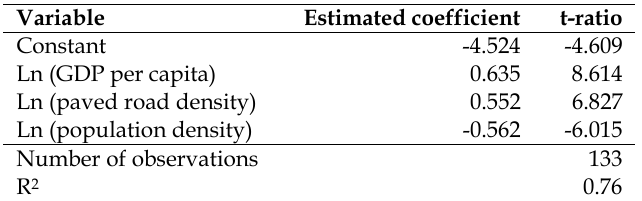
Table 1. Country estimation results for motorisation - Variable Estimated